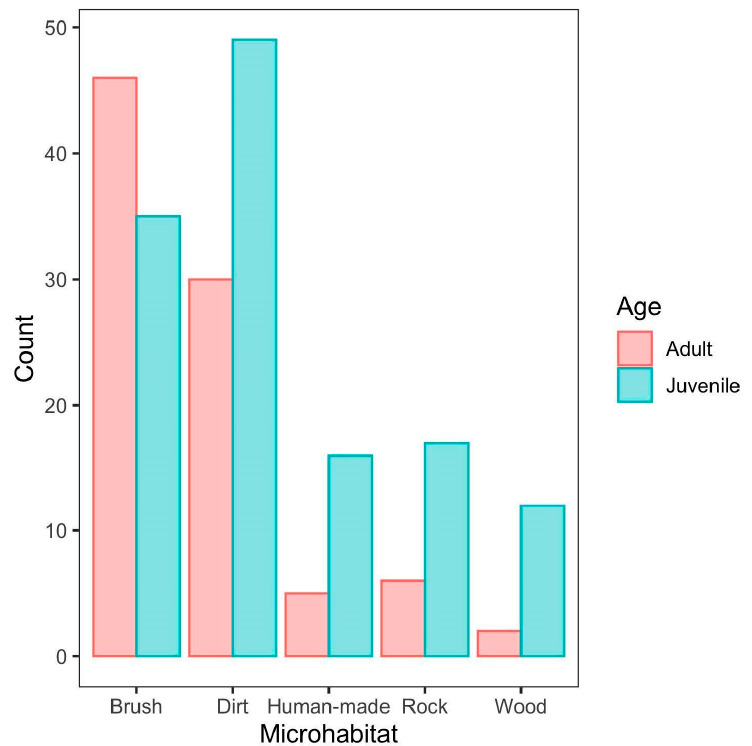
Figure 3. Microhabitat Distribution. The relationship between microhabitat utilization and age group. We could only assess 78 out of the 220 observations for ground level hunting (hunt- ing on ground vs. on an elevated perch) due to most photographs not containing enough background imagery around the snake. We found that the effect of age on ground level hunting was marginally non-significant ( X 2 = 3.674, df = 1, p = 0.052). Juveniles were more likely to be found on an elevated perch (25% of the time), while adults were almost exclu- sively found at ground level, and were only found on elevated perches 6% of the time. We found that age had an effect on seasonal activity ( X 2 = 12.371, df = 3, p = 0.006). Juveniles were most commonly observed during spring (52% of all observations) while observations of adults were more evenly dispersed throughout all four seasons with a slight peak during spring (Figure 4).